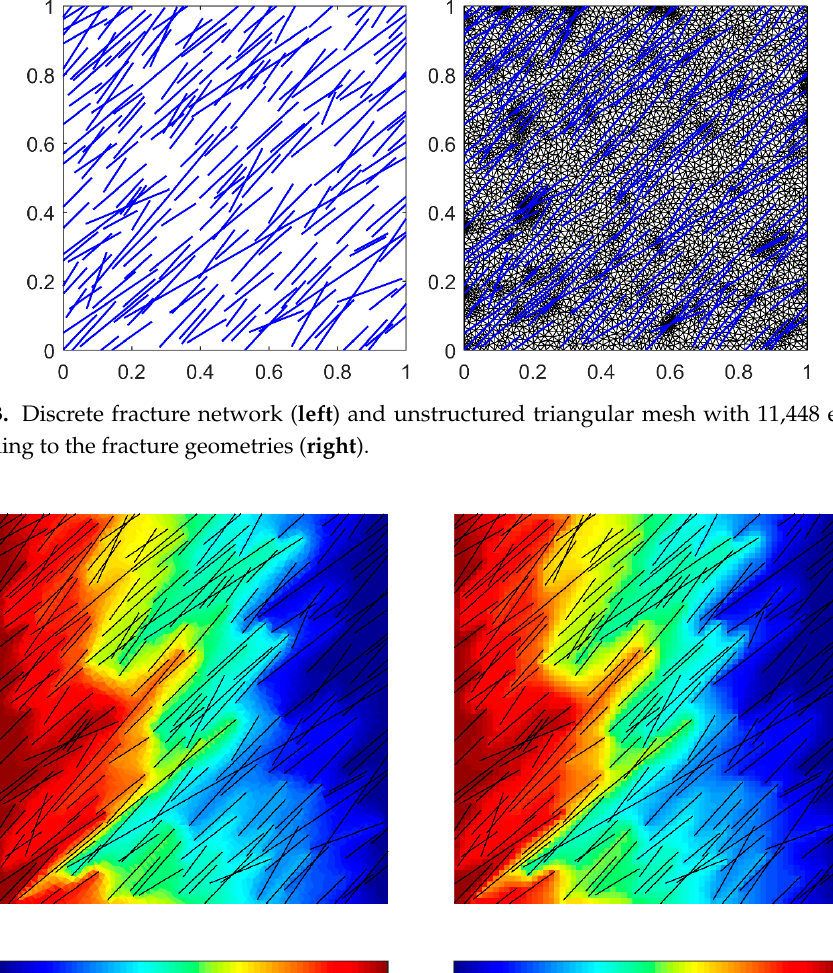
Figure 4. Pressure distribution using DFM-NTPFA ( left ) using 11,448 elements and EDFM-TPFA ( right ) using 4900 elements (i.e., 70 × 70) blocks.